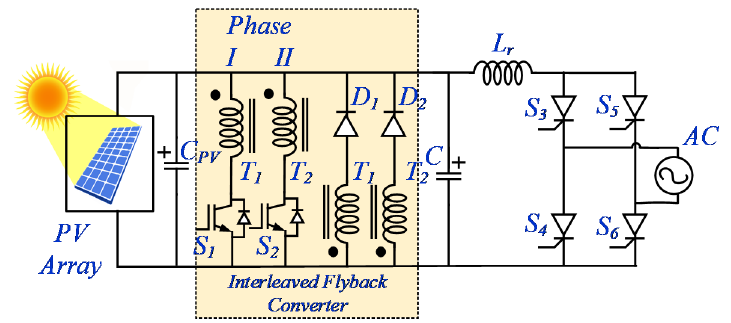
Figure 24. Single stage fly-back inverter with soft switching.